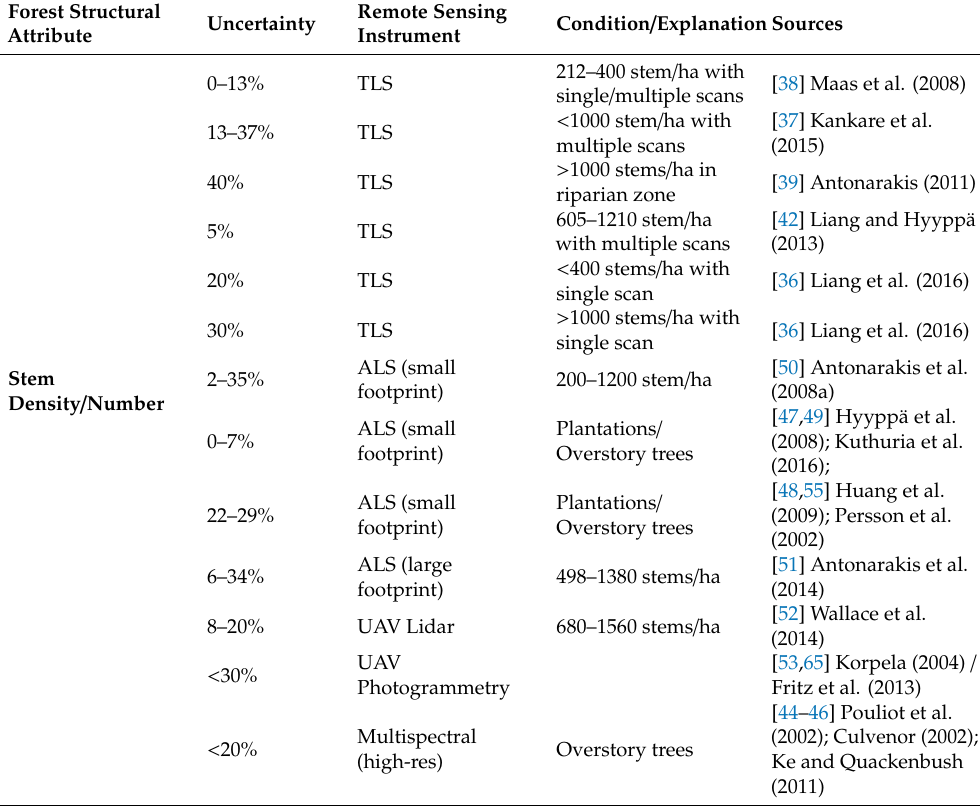
Table 1. Uncertainty in estimates of deriving stem spacing and trunk diameter obtained in previous studies using various remote sensing instruments and